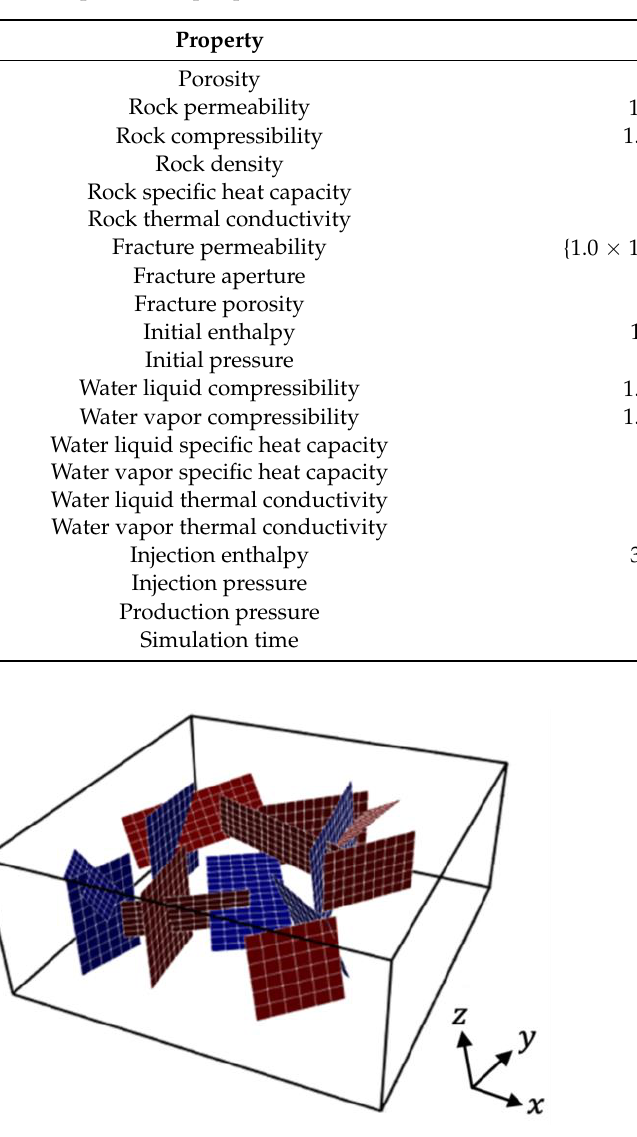
Table 2. Input parameters used in the multiphase flow test case. Thermodynamic properties for water of liquid and vapor phase are referred to [40].